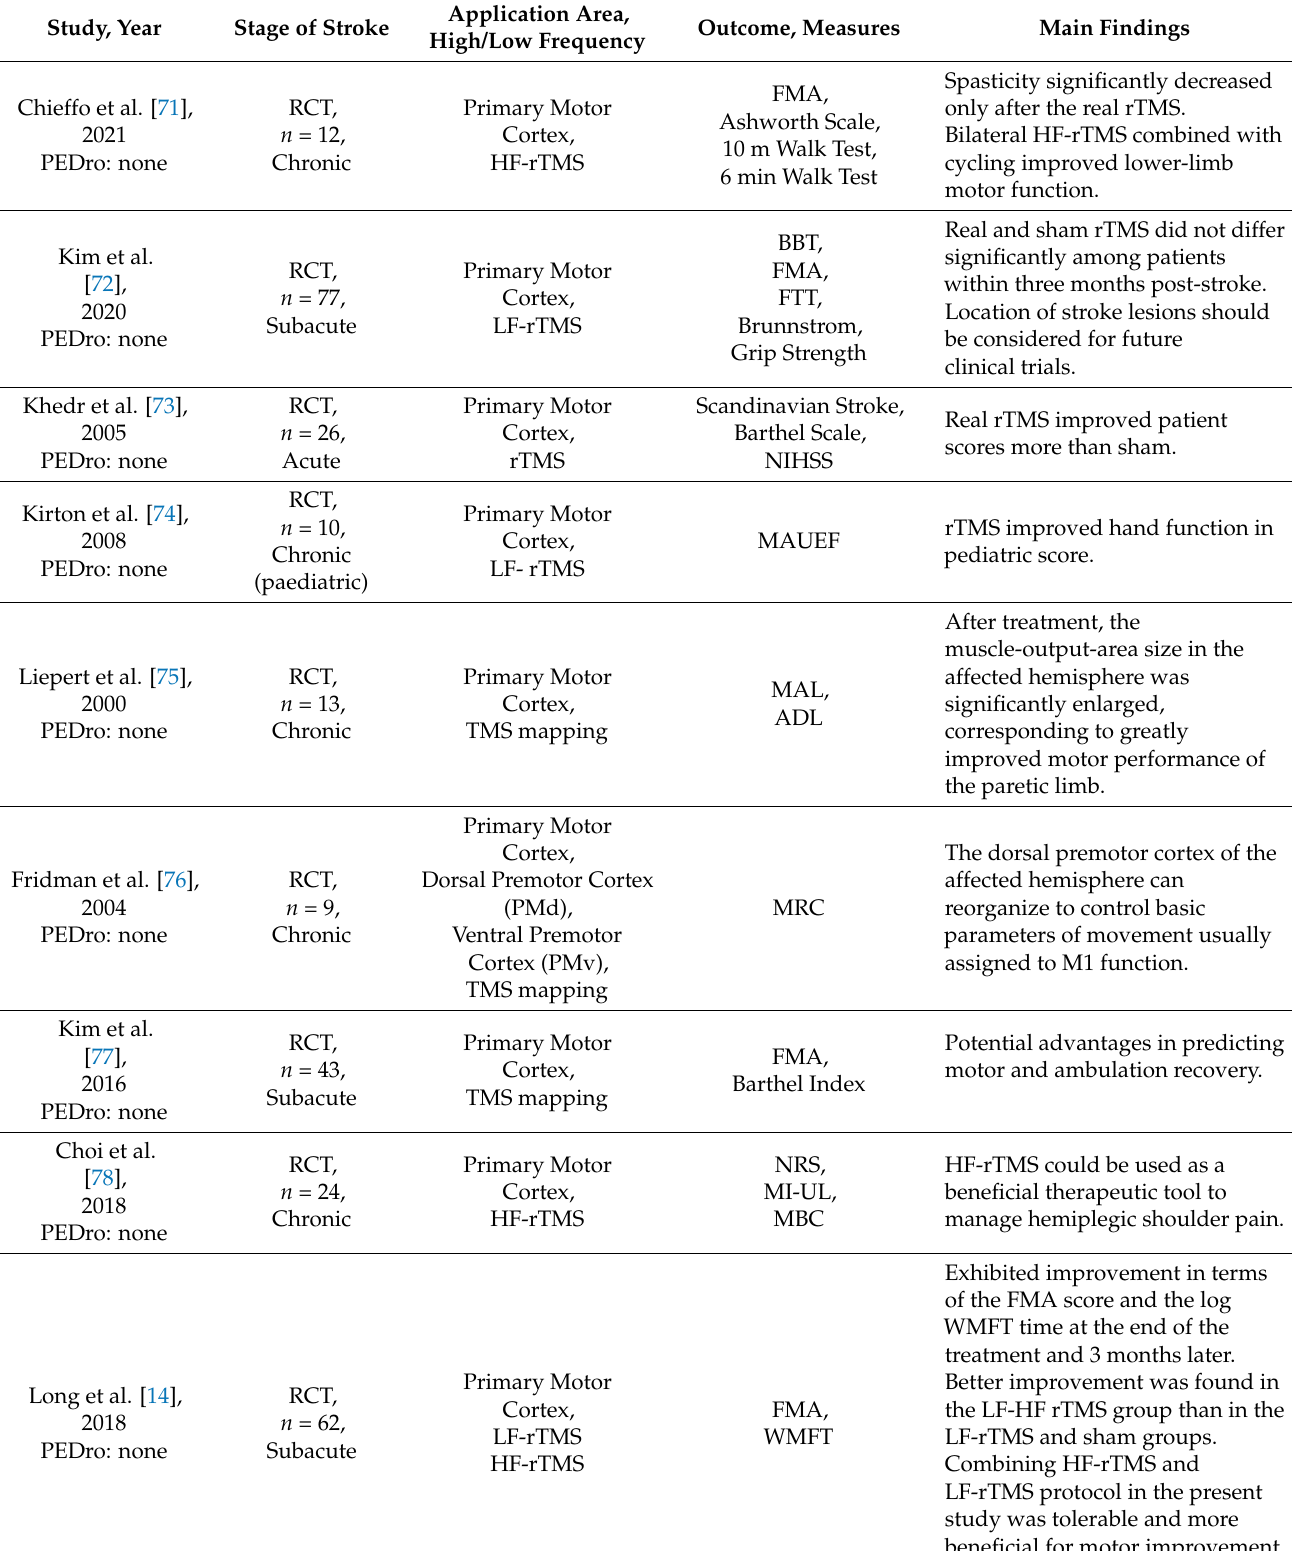
Table 1. Summary of potential benefits in motor functioning after using TMS therapy after stroke in RCTs with a valid measure of the methodological quality of clinical trials using the PEDro